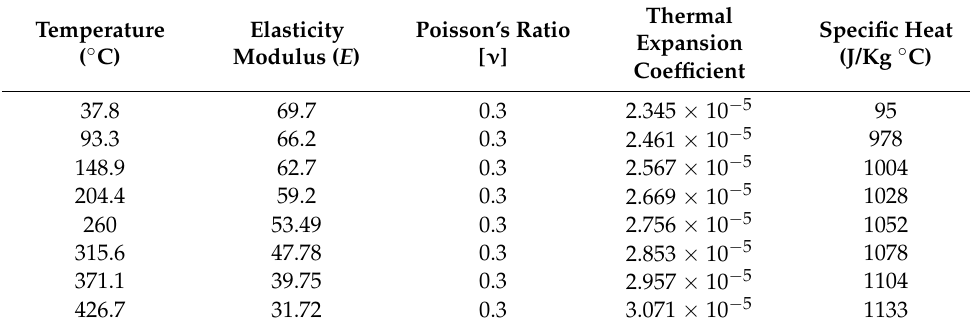
Table 2. AA 6061-T6 properties (temperature-dependent).